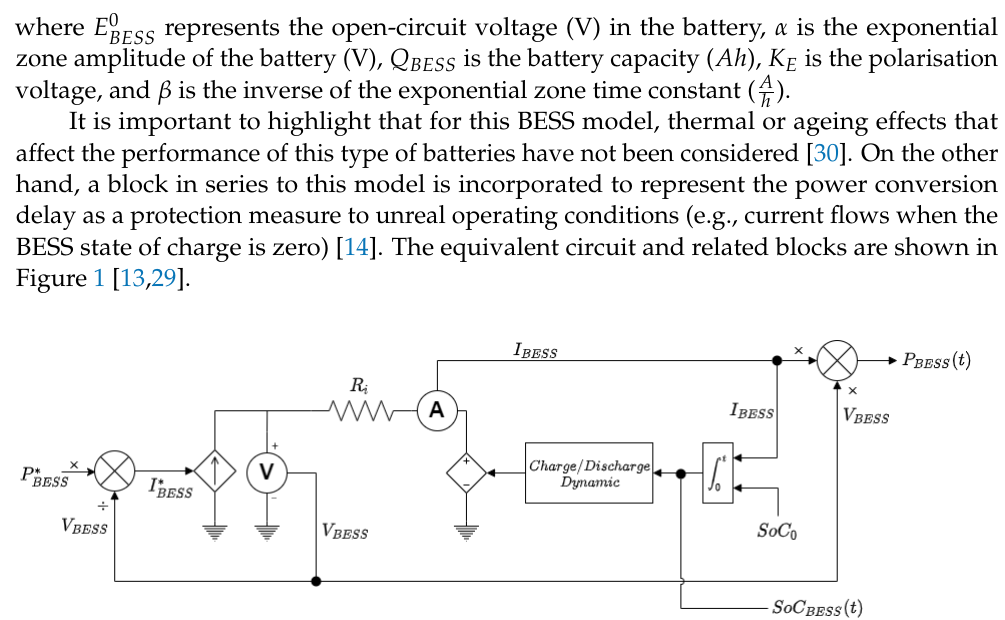
and I ∗ denote the power reference and and BESS BESS